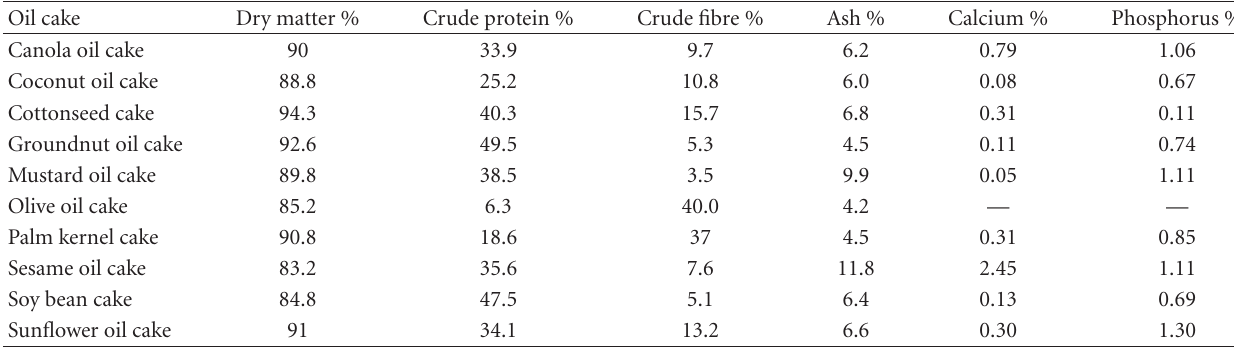
Table 3: Composition of oil cakes.